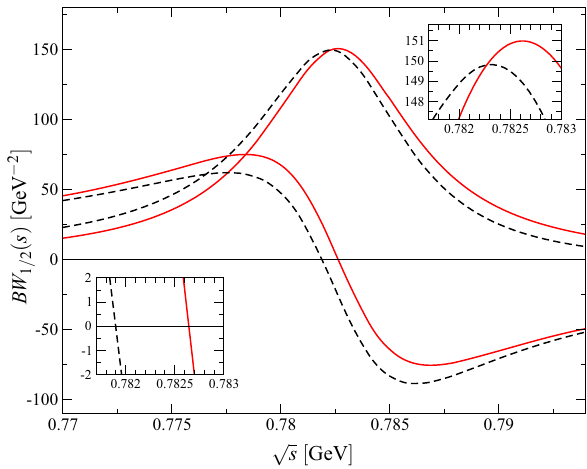
Fig. 4 The line shapes of the amplitudes BW 1 ( s ) and BW 2 ( s ) defined in Eqs. (23) are shown as ( red ) solid and ( black ) dashed lines . The peaked lines refer to the imaginary parts, while the ones with a zero refer to the real parts. The inserts magnify the regions of the zero- crossing of the real parts ( bottom left ) as well as the maximum of the imaginary parts ( top right